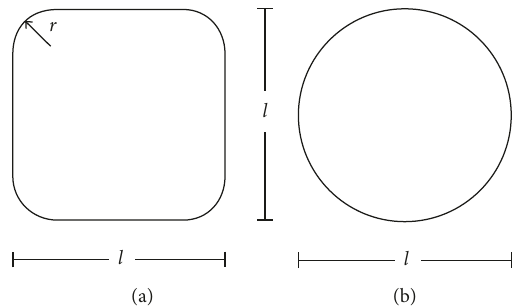
Figure 1: Details of transverse section of columns. (a) Square shape. (b) Circular shape.